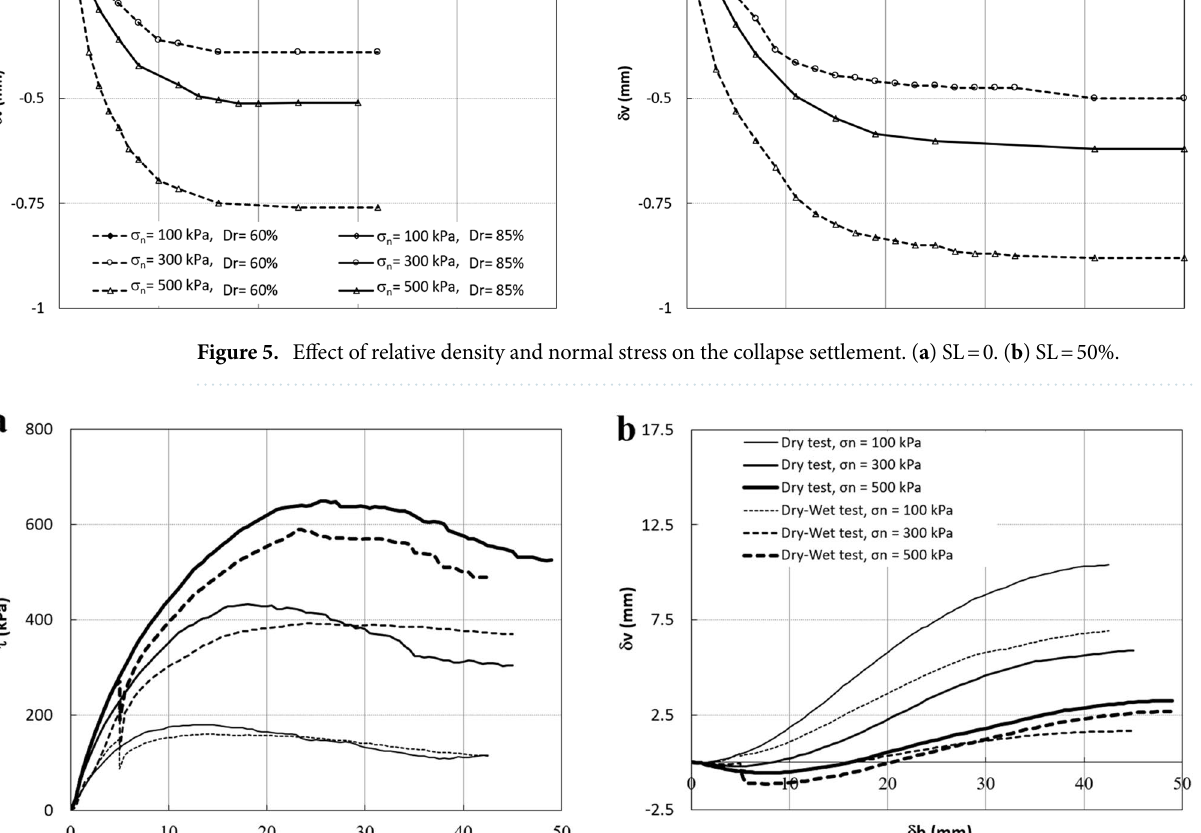
are shown with solid and dashed curves, respectively. Figures 6a and 7a show that the shear strengths of the dry samples are higher than those from the dry–wet tests at the same vertical stresses. This is because samples in the latter tests were inundated before they reached their peak strength. The stress relaxation occurs in all dry–wet tests in both specimens with angular and sub-angular particles. It can be seen that the stress relaxation increases